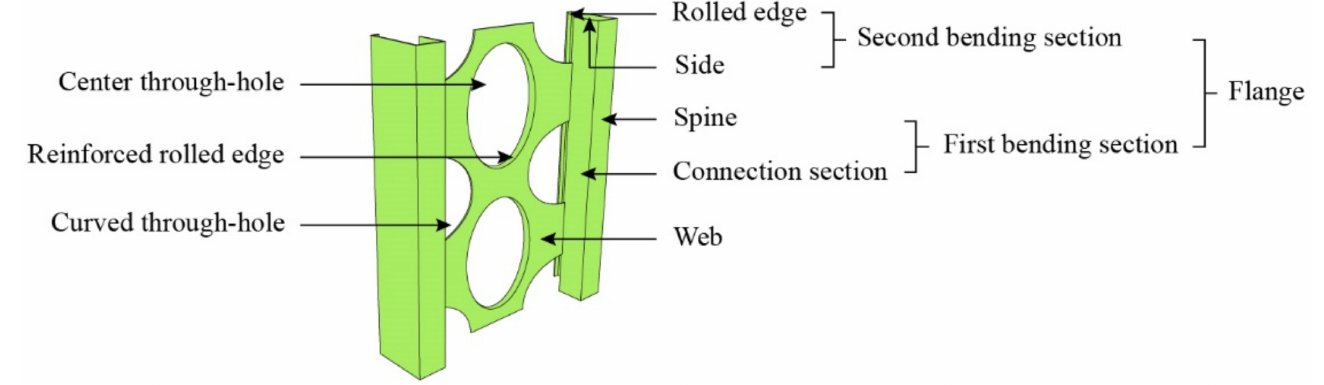
Figure 1. M-section steel